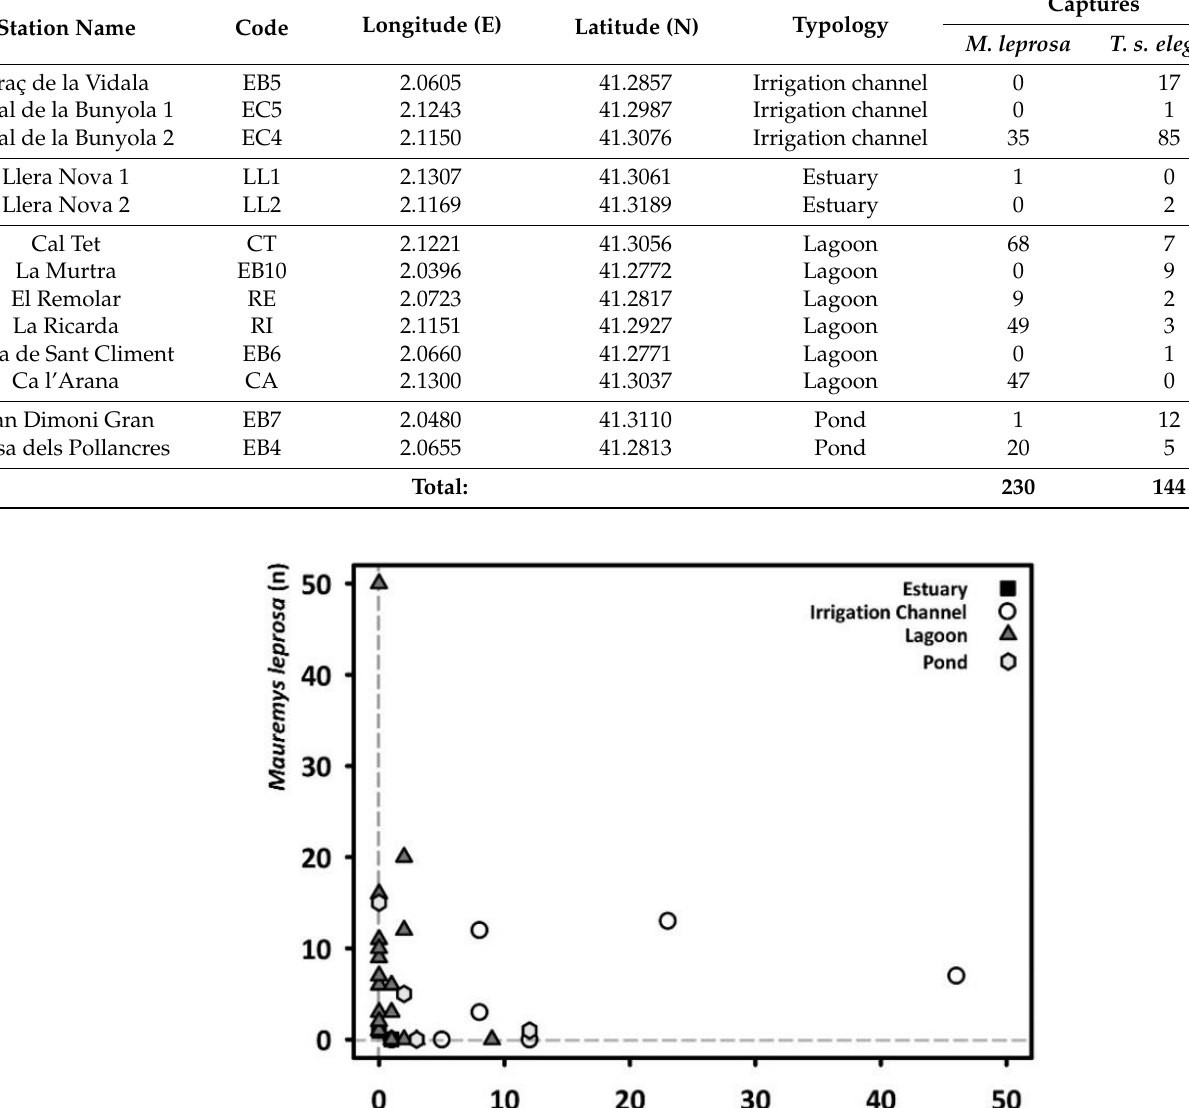
Table 3. Sampling stations and number of captures per species.